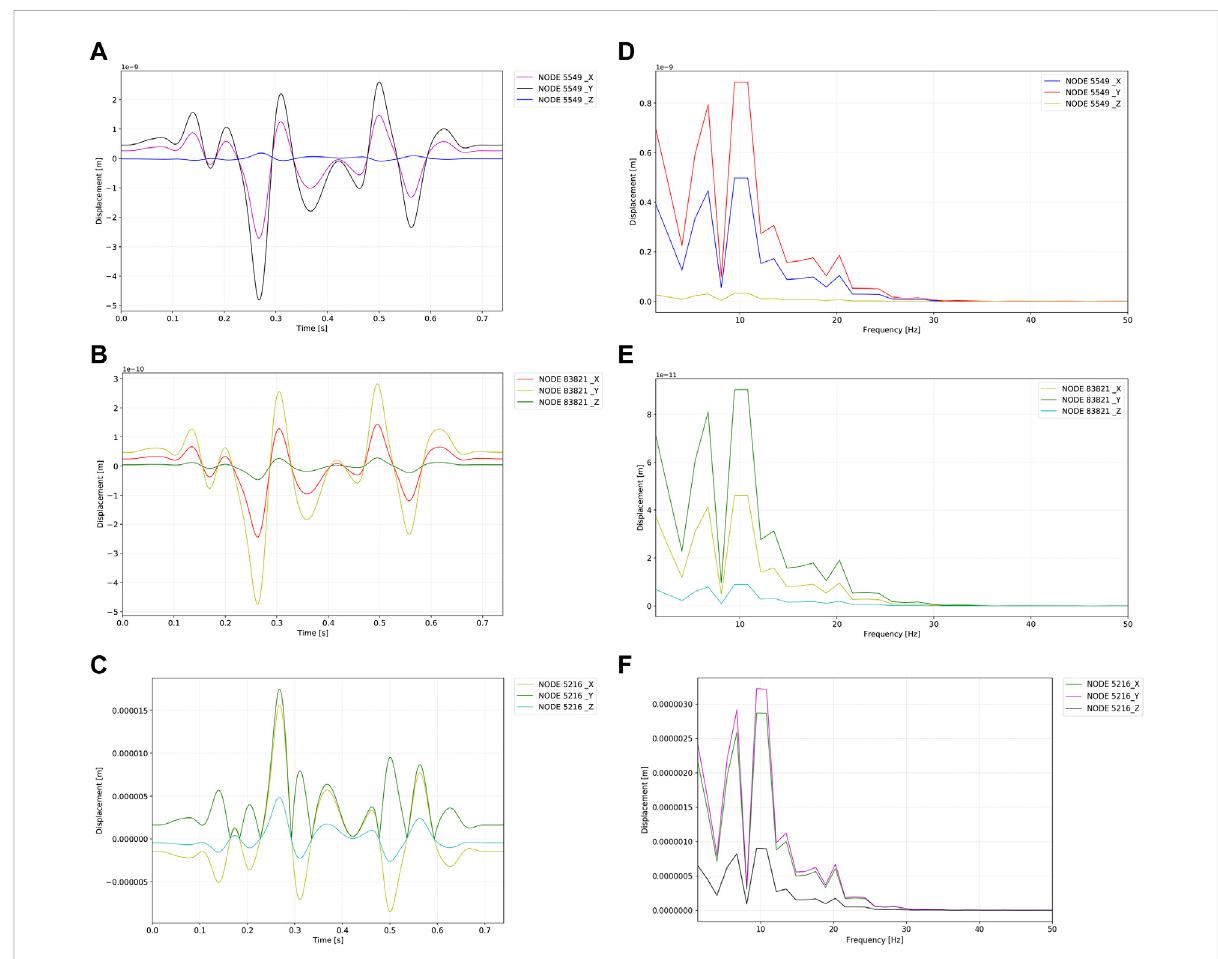
FIGURE 8 Displacement pro fi les of the observed nodes. Units in graphs A to F are meters. (A) Time – displacement of the internal surface of the sigmoid sinus vessel wall underneath dehiscence (node 5,549). (B) Time – displacement of the sigmoid plate underneath dehiscence (node 83,821). (C) Time – displacement of the brain side internal surface of the sigmoid sinus vessel wall (node 5,216). (D) Frequency – displacement of the internal surface of the sigmoid sinus vessel wall underneath dehiscence (node 5,549). (E) Frequency – displacement of the sigmoid plate underneath dehiscence (node 83,821). (F) Time – displacement of the brain side internal surface of the sigmoid sinus vessel wall (node